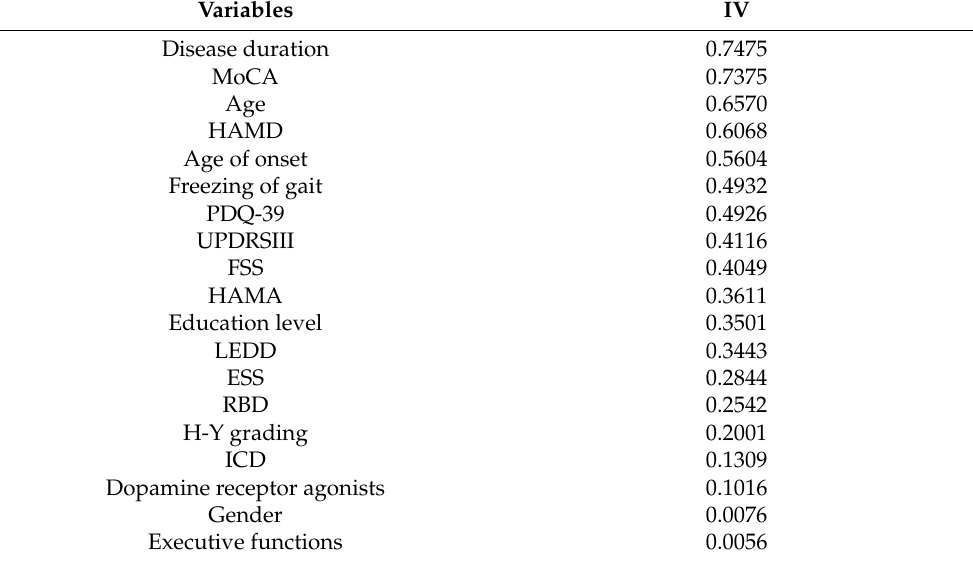
Table 2. Information value.